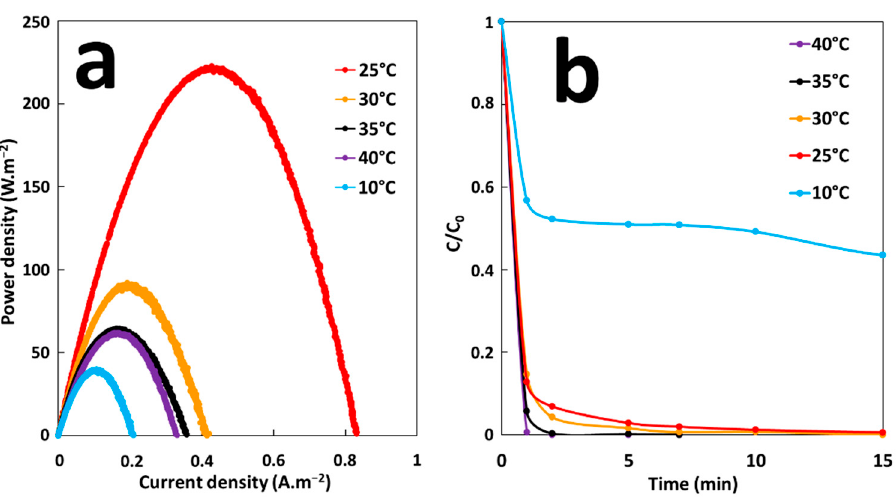
Figure 8. ( a ) Power curves of the GF process obtained at different temperatures and ( b ) Effect of temperature on the degradation of MG dye during the GF process.